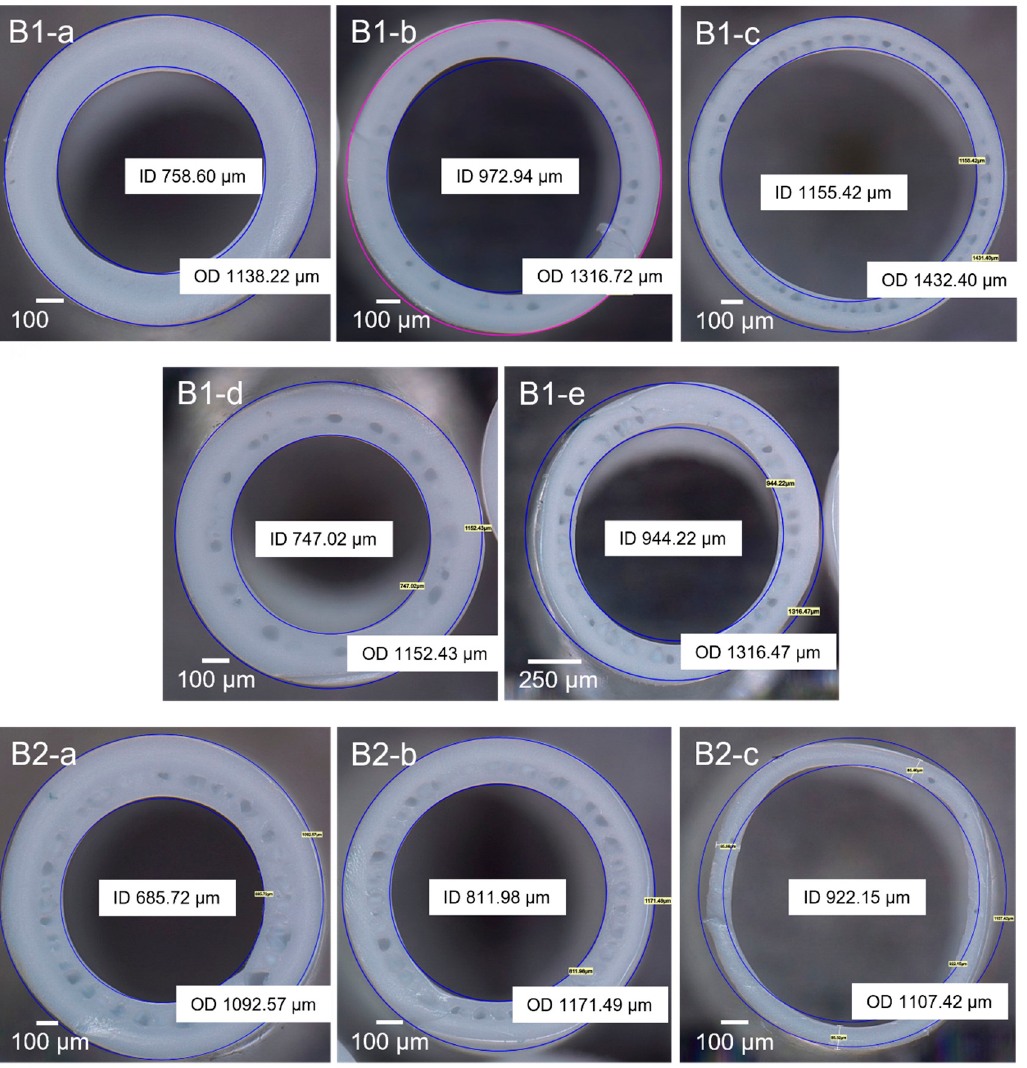
Figure 3. Changes in membrane morphology with changes in spinning conditions. B1: samples from PVDF 1 dope. B2: samples from PVDF 2 dope .